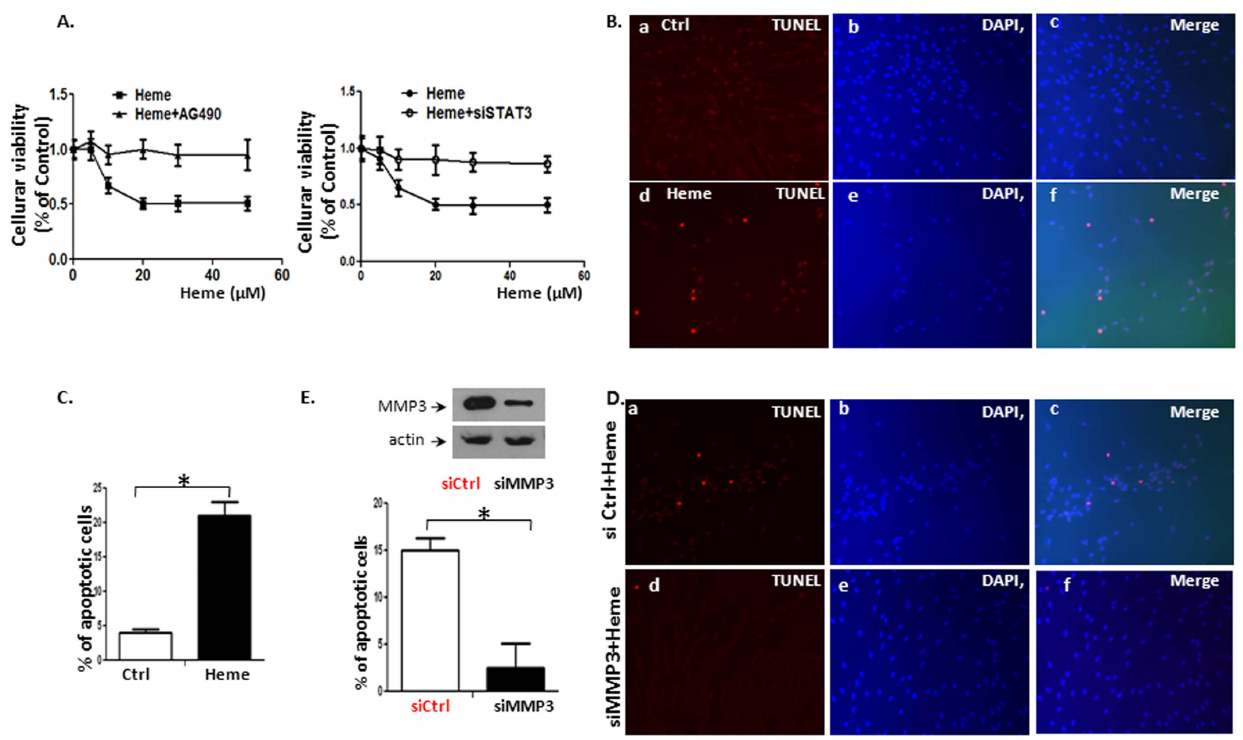
Figure 6. STAT3 induces apoptosis through MMP3 in HBVEC cells. HBVEC were treated with 30 m M of Heme for 24 h followed by evaluation of cell death and apoptosis using MTT and TUNEL assay. Cell death progression in HBVEC cultured were conducted by treating HBVEC cells with AG490 (50 m mol/L) or siSTAT3 as well as corresponding controls followed by incubation with Heme for 24 h, then assayed by MTT measurement. The curves correspond to 3 experiments run in parallel. Heme induced 20%–50% of cell death when treated with 10 to 40 m M of Heme for 24 h (Figure 6A) with 20–30 m M causing maximum effects. The cell death can be rescued by JAK inhibitor AG490 (Figure 6A, left panel) and siSTAT3 (Figure 6A, right panel, * p , 0.05, n=3 triplicate experiments). The reduced cell viability by Heme was further discovered to be caused by cell apoptosis (Figure 6B and 6C). The apoptotic cells were found to be increased by Heme treatment (compare Figure 6B–d vs. 6B–a, 6B–f vs. 6B–c and 6C) using TUNEL assay. When HBVEC cells were transfected with siMMP3 followed by treatment of Heme for 24 h, number of apoptotic cells were reduced (compare Figure 6D–d vs. 6D–a, 6D–f vs. 6D–c and 6E). Upper panel of panel E confirmed specific MMP3 down regulation by siMMP3 by Western